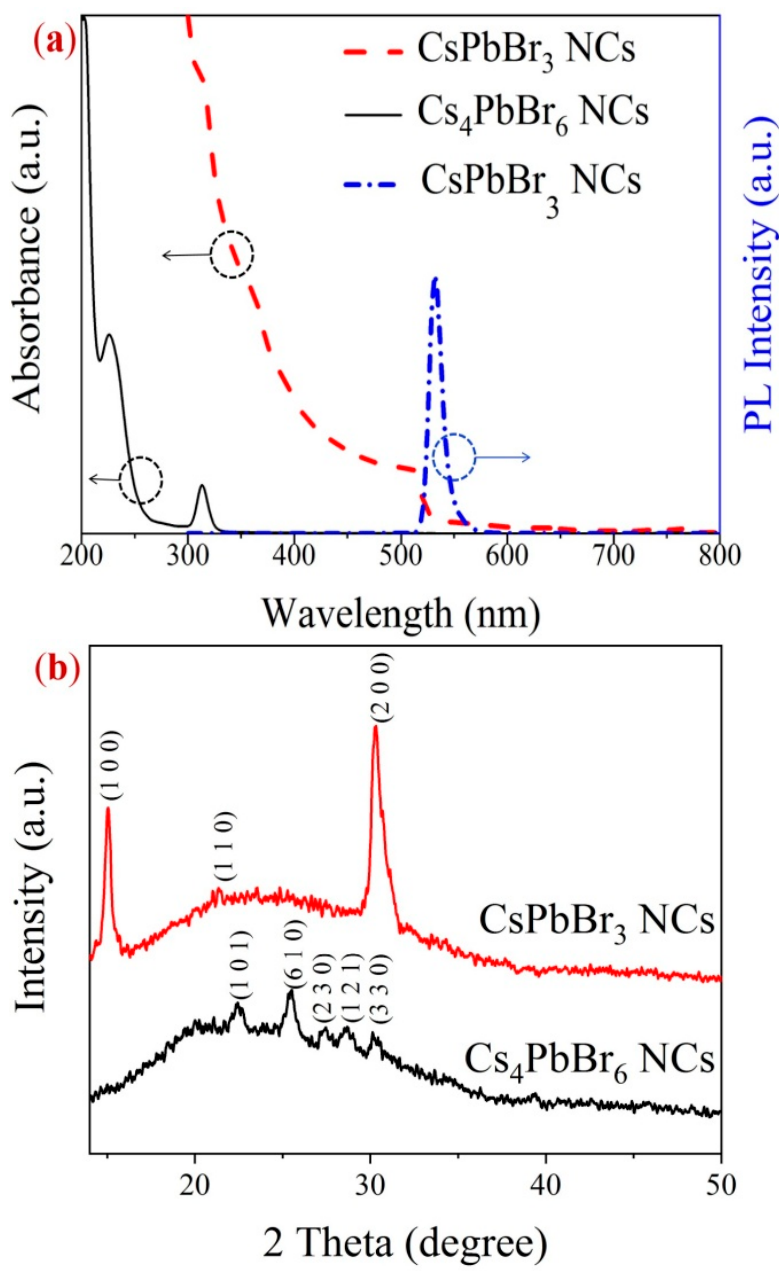
Figure 3. ( a ) Absorption and photoluminescence (PL) spectra and ( b ) X-ray diffraction (XRD) patterns of Cs 4 PbBr 6 and CsPbBr 3 NCs. The background of XRD patterns in ( b ) is shifted because of artificial translation of Y-axis.